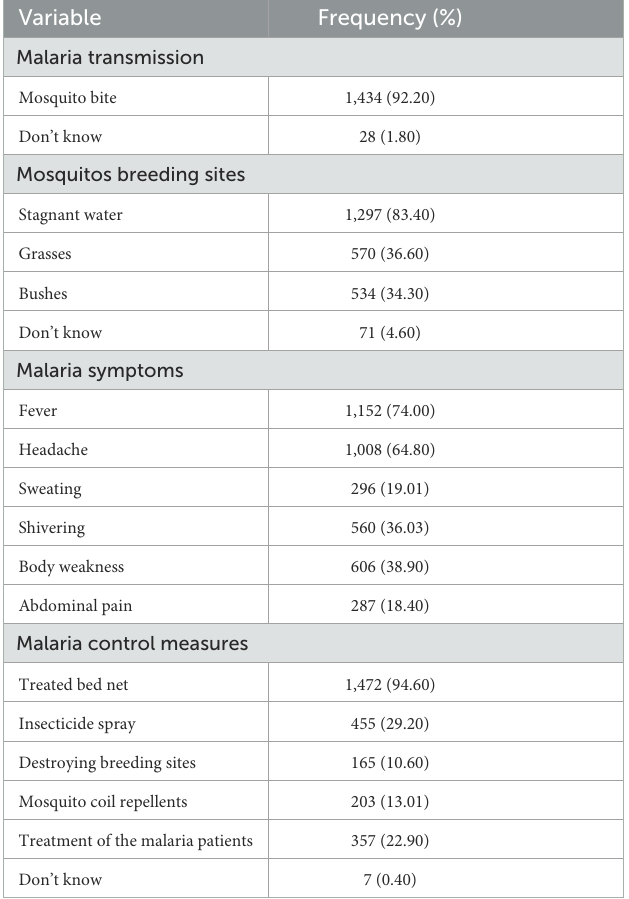
TABLE 2 Study population knowledge of malaria